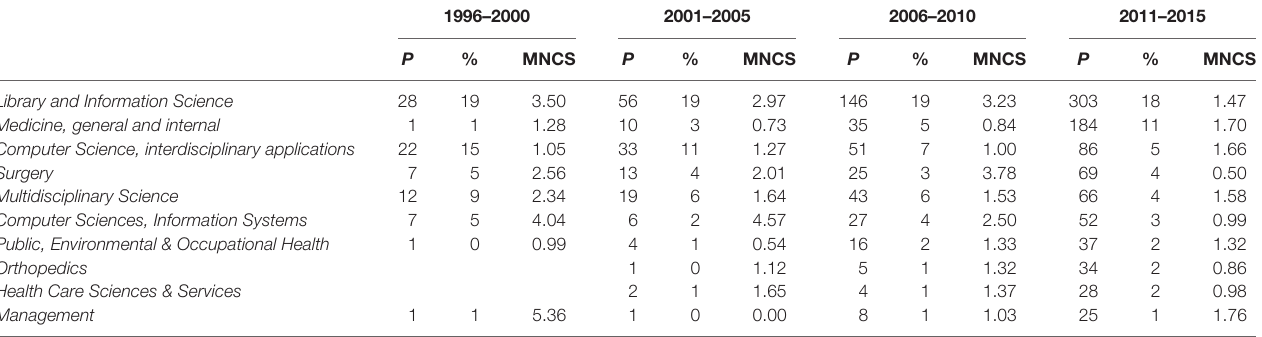
TaBle 4 | Output numbers across fields in Wos on Journal impact Factors, 1996–2015.